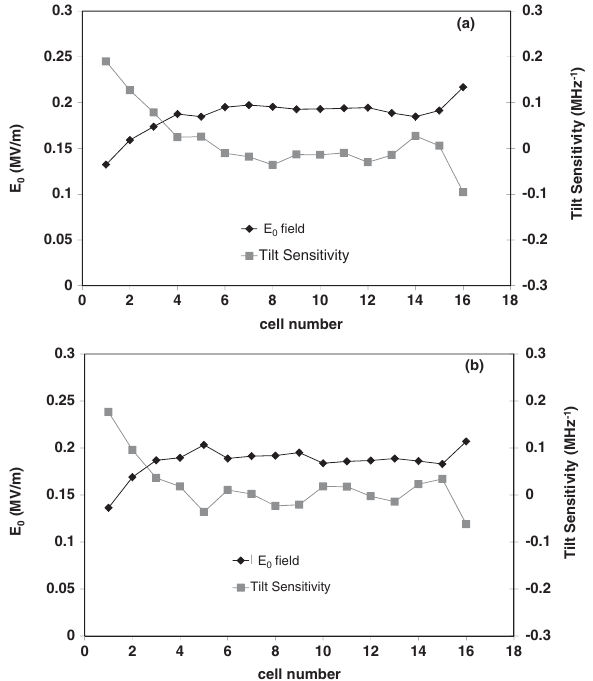
7 PCs. One can see the tilt sensitivity curve approaching to zero, except that for the cells close to the tank ends (Fig. 30).